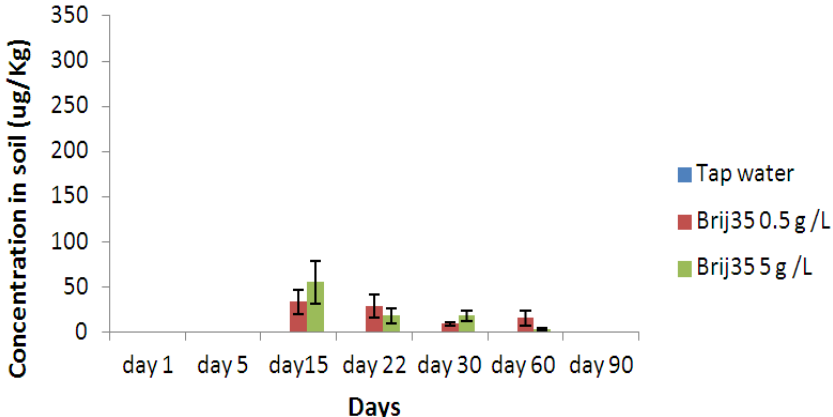
Figure 7. Metribuzin concentrations at 0.6 m